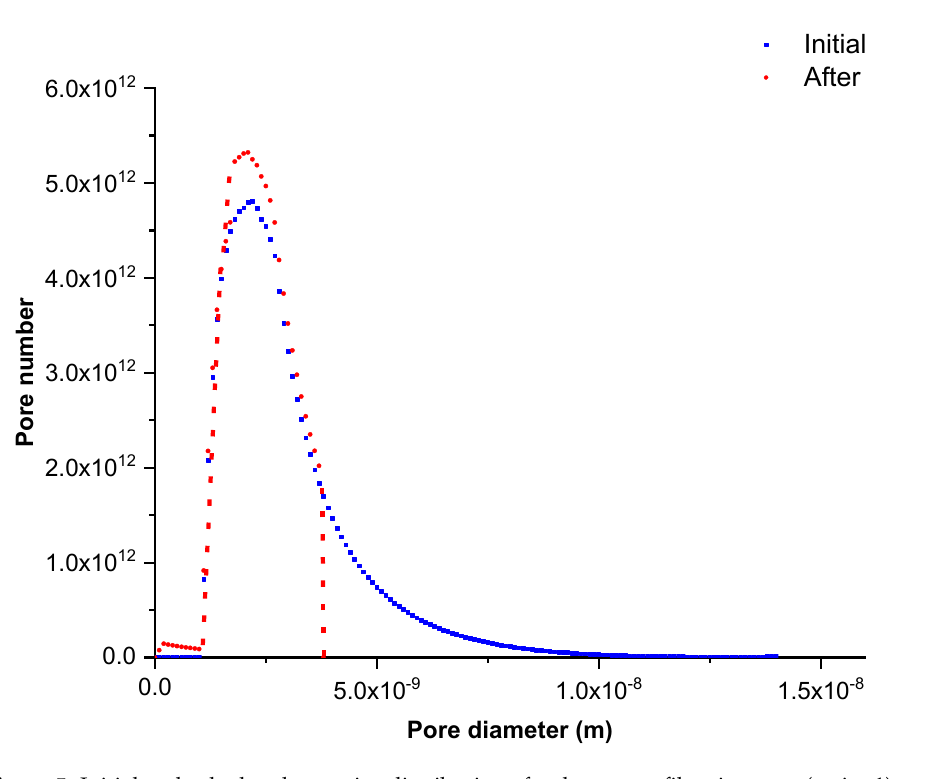
Figure 5. Initial and calculated pore size distribution after lysozyme filtration tests (series 1).